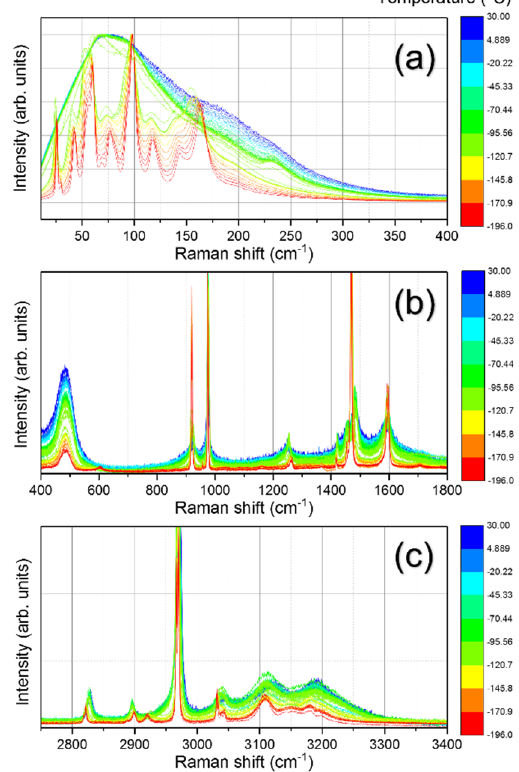
Figure 4. (Color online) Temperature-dependent Raman spectra of the MAPbCl 3 single crystal in 10–400 cm − 1 ( a ), 400–1800 cm − 1 ( b ), and 2700–3400 cm − 1 ( c ) frequency ranges from room temperature down to − 196 °C.